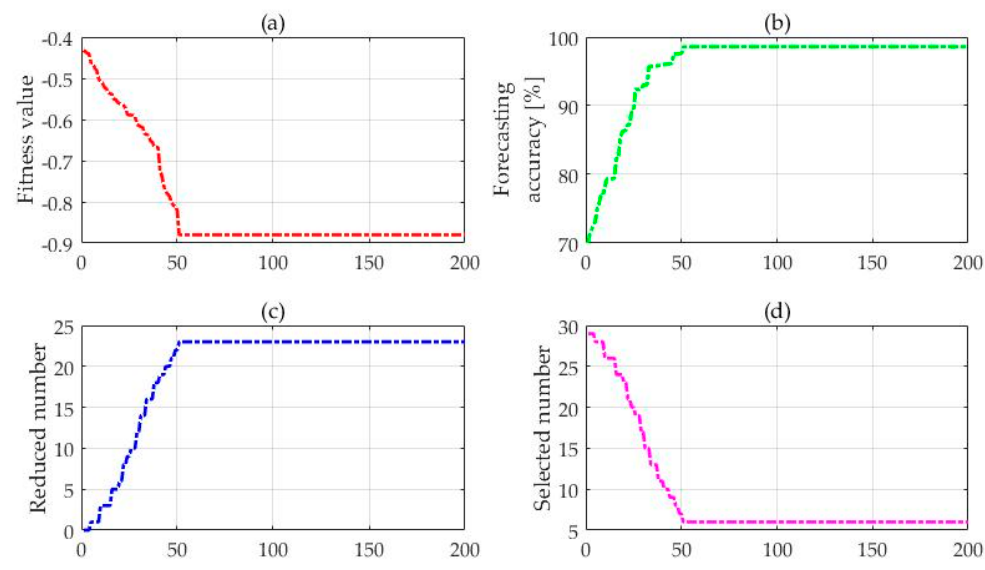
Figure 5. The curve of convergence for feature selection. Note: ( a ) represents the fitness value; ( b ) represents the forecasting accuracy; ( c ) represents the reduced number of candidate feature; and ( d ) represents the selected number of optimization feature.